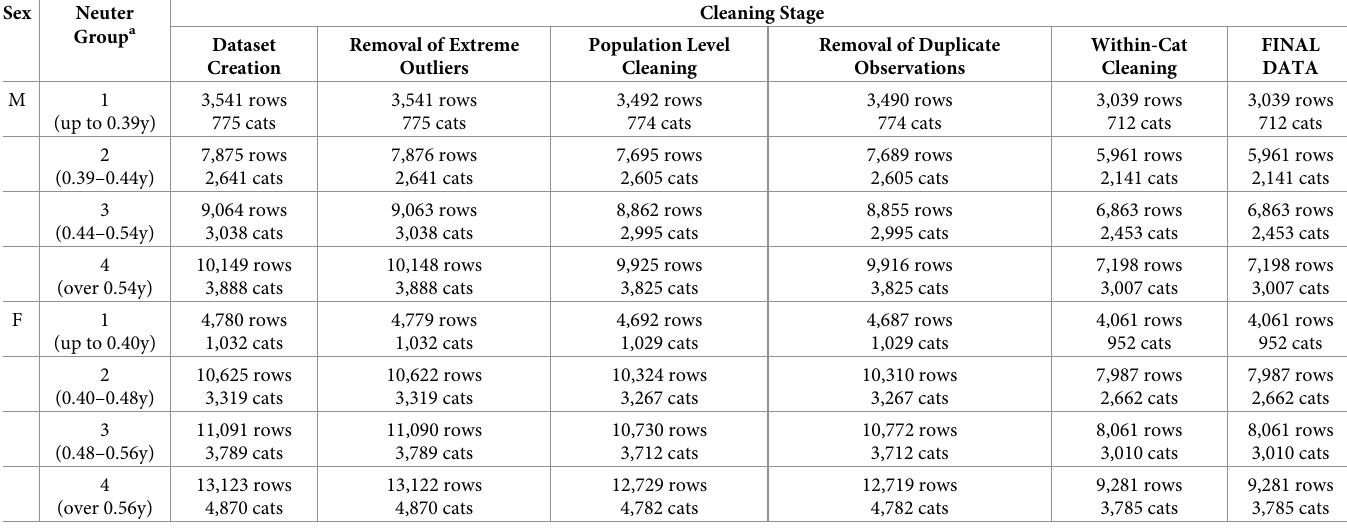
Table 1. Details of the data subsets for Study 1 at each stage of data